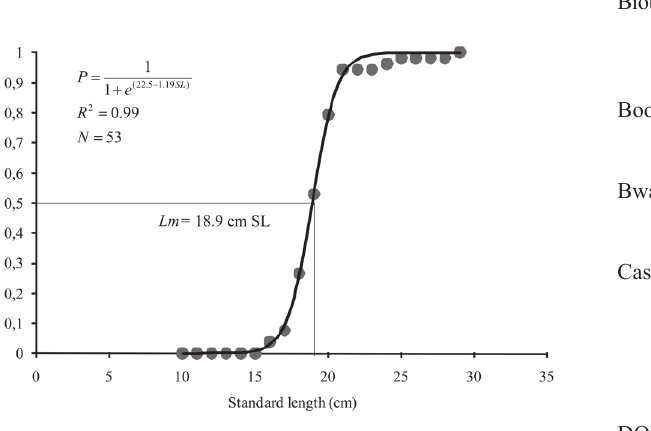
Fig. 7. Size at first maturity of the Sinaloa cichlid Cichlasoma beani in the Aguamilpa Reservoir in Nayarit,